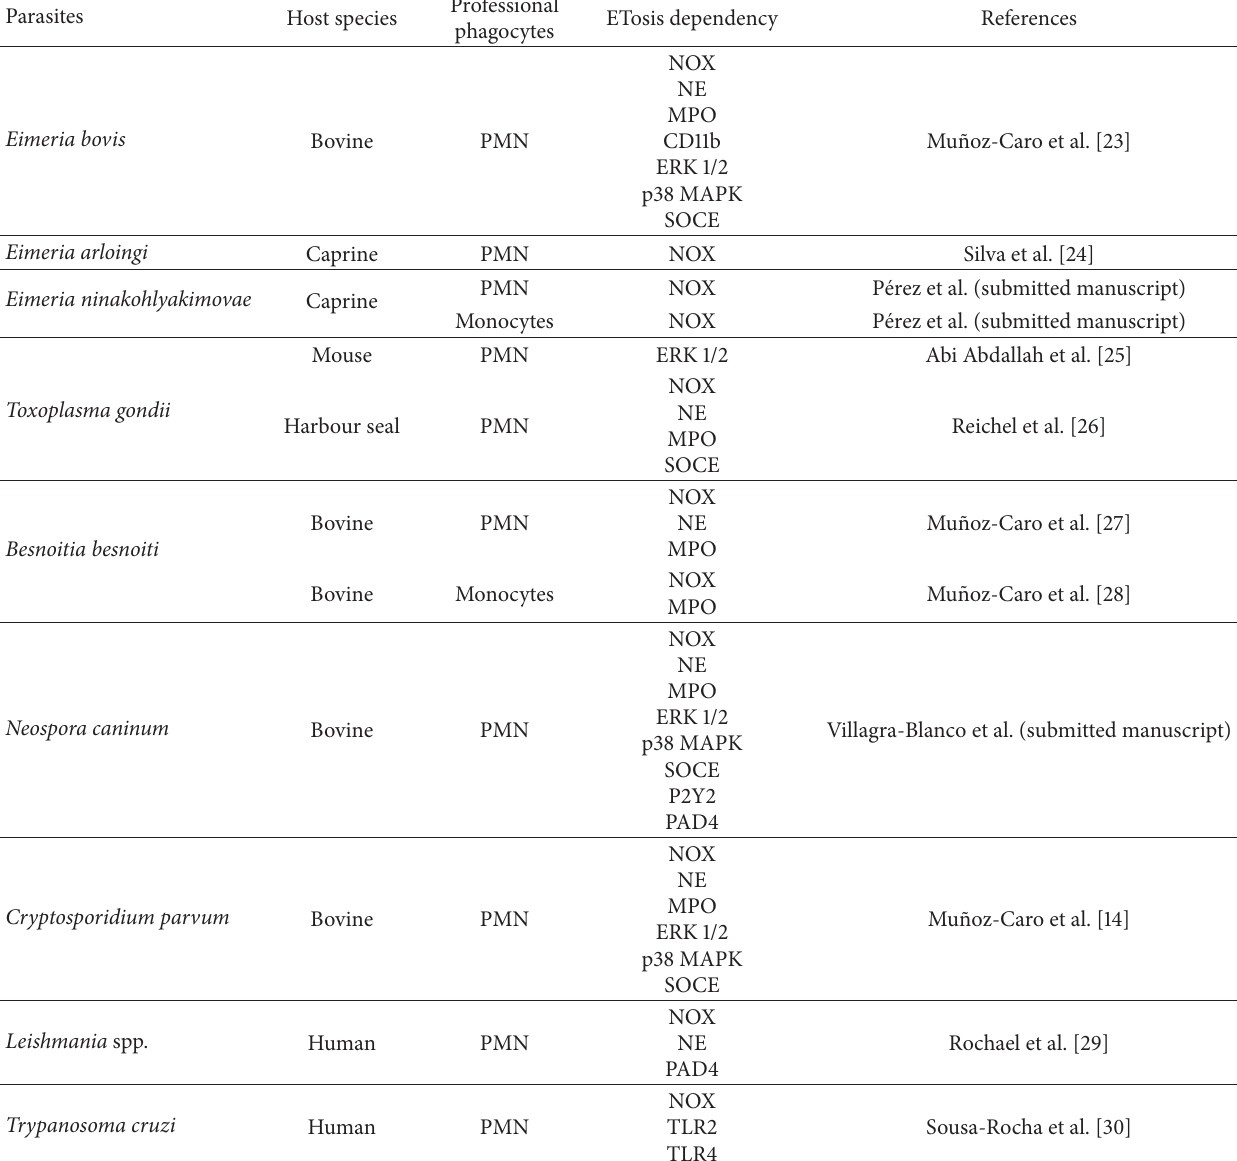
Table 1: List of apicomplexan and euglenozoan protozoa capable of inducing ETosis, host species, professional phagocytes triggering ETs, and molecular mechanisms involved in this cell death